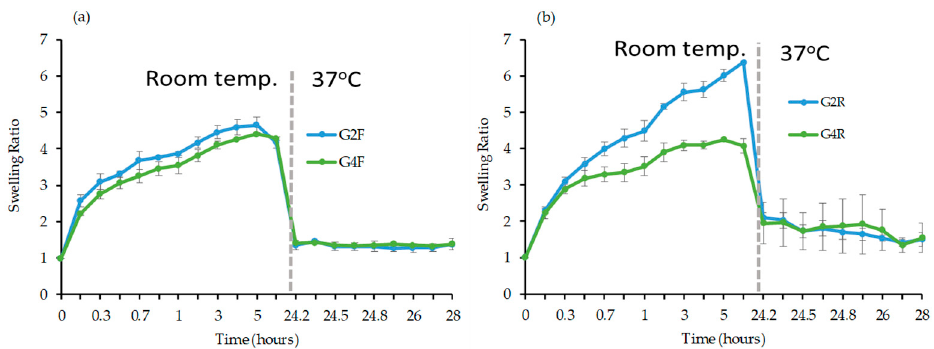
Figure 4. Evolution of the SR as a function of time in deionized water at room temperature for the first 24 h and then at 37 °C (shown as a grey line) for another 4 h for PNIPAAm gels ( a ) G2F and G4F and ( b ) G2R and G4R.